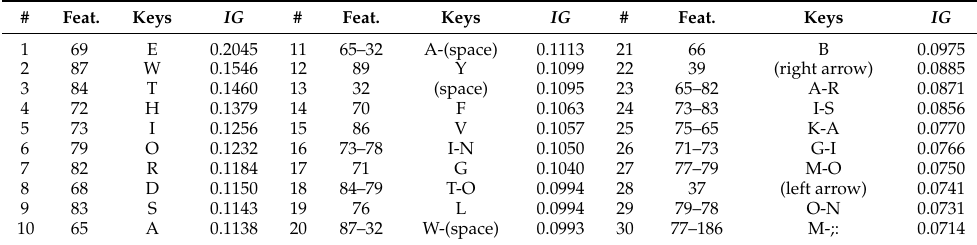
Table 3. Keystroke dynamics features with the highest information gain ( IG ) in gender–age classification.